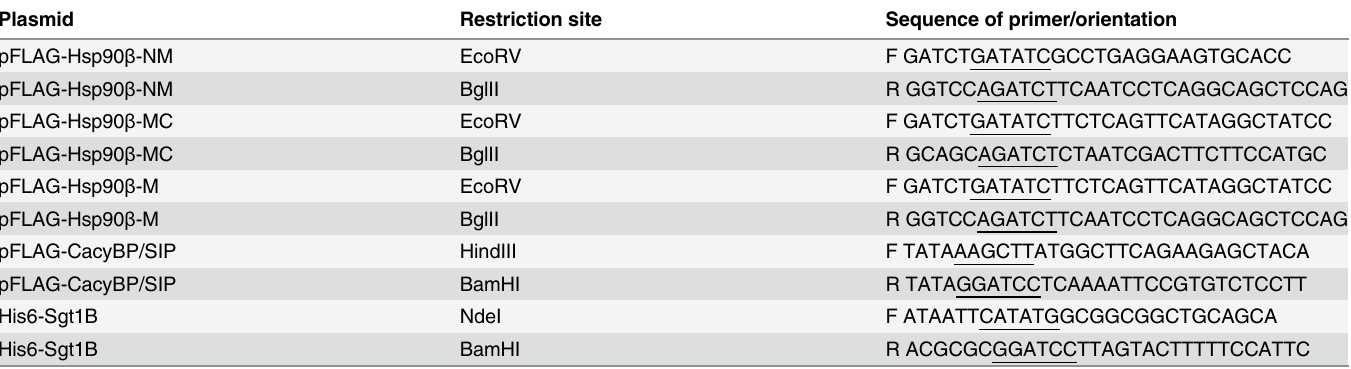
Table 1. List of restriction enzymes and primers used for